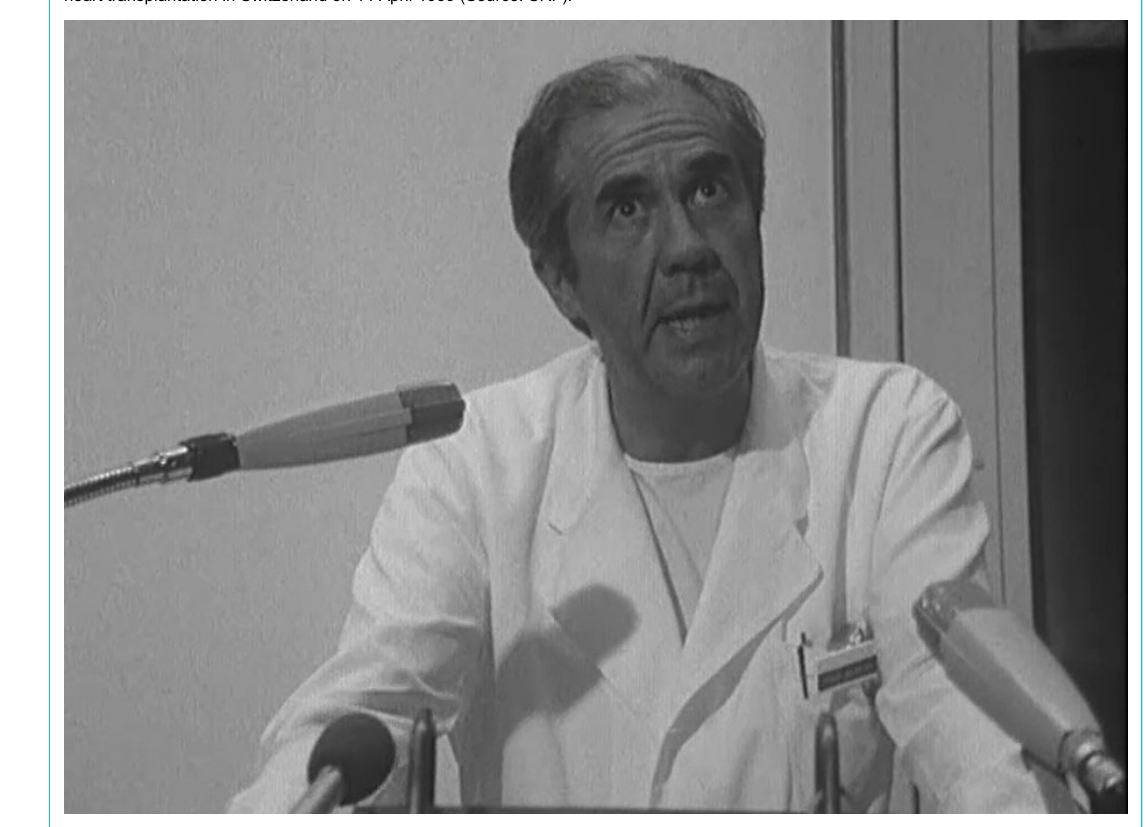
Figure 1: Åke Senning during the press conference held in the auditorium of the former Cantonal Hospital Zurich after the first successful heart transplantation in Switzerland on 14 April 1969 (Source: